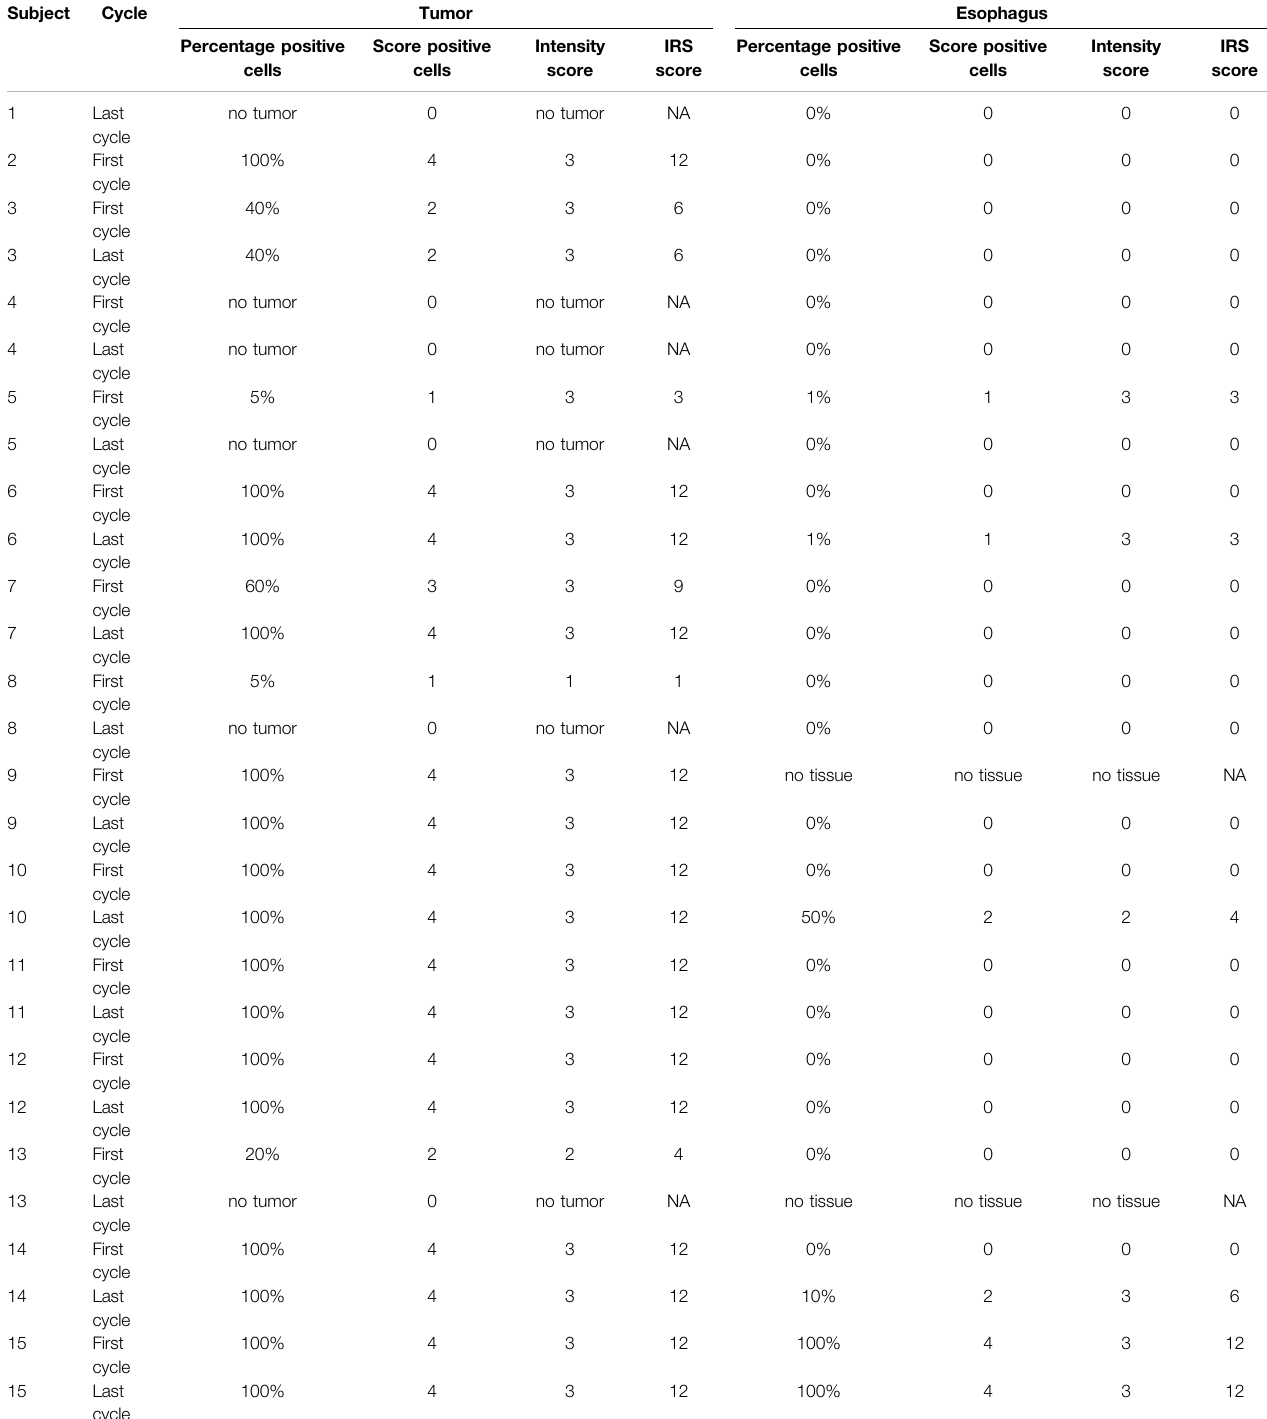
TABLE 3 | Immunohistochemical score of ABCB1 per